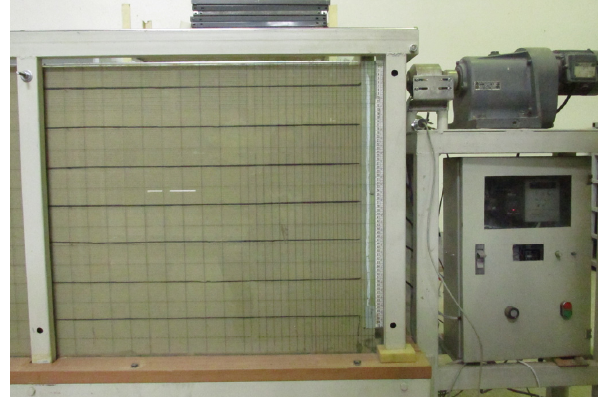
Figure 2. Picture of model box.